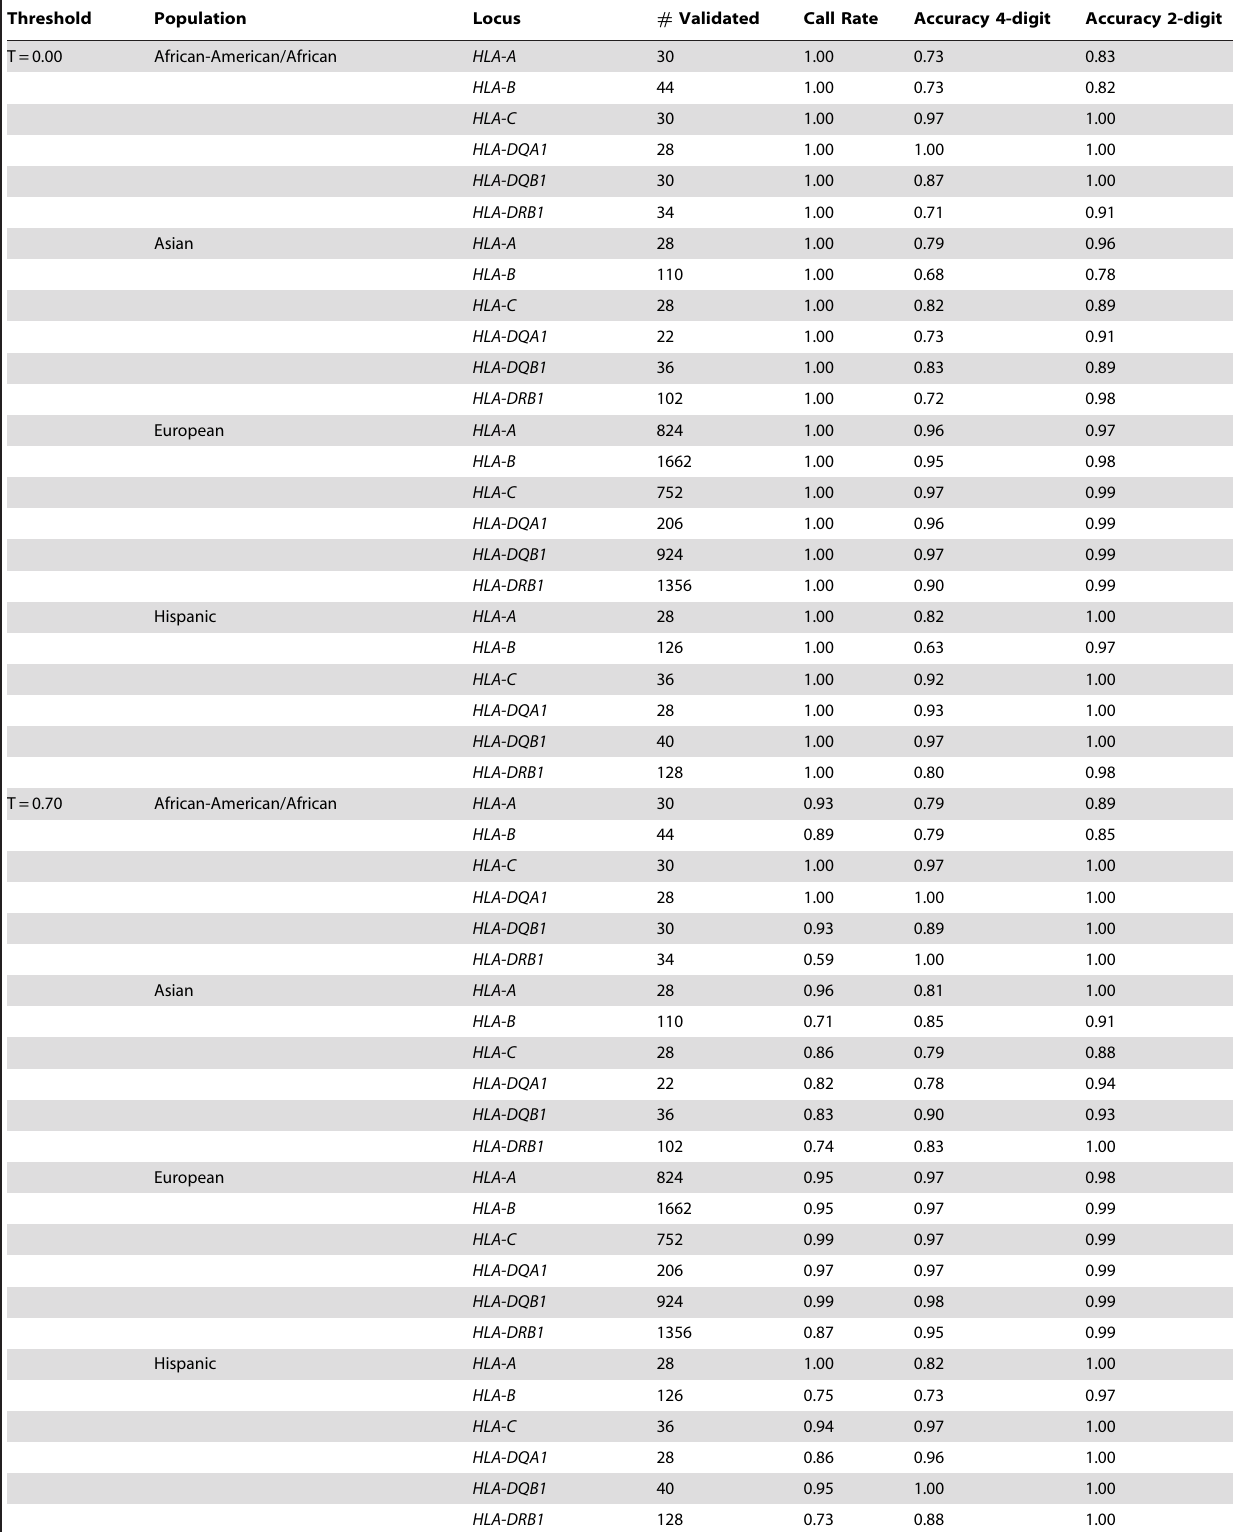
Table 5. Multi-ethnic validation results.